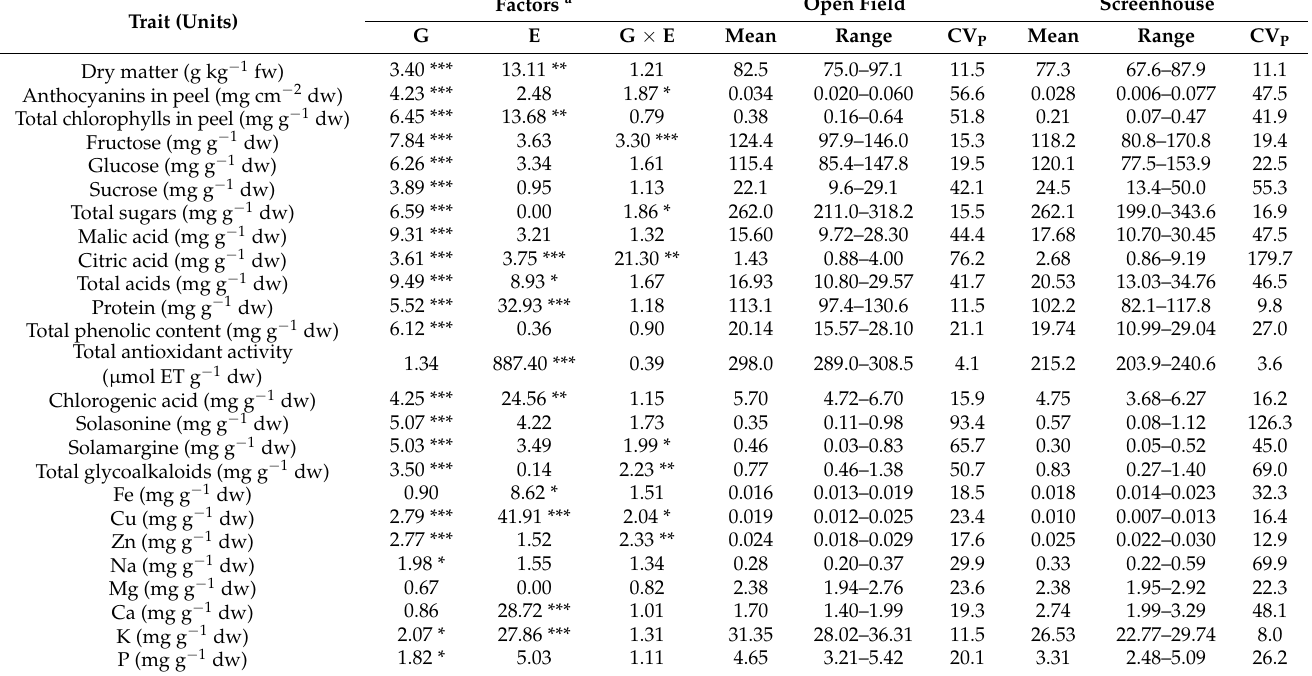
Table 2. F-ratio values for genotype (G; 16 ILs plus the recipient parent AN-S-26), environment (E; open field and screenhouse), and genotype per environment interaction (G × E), obtained from the bifactorial ANOVA, and significance of each effect for each trait. Mean, range, and phenotypic coefficient of variation (CV P ) of the ILs, together with the recipient parent, under both open field and screenhouse are also shown. Units are expressed on a dry weight (dw) basis except for dry